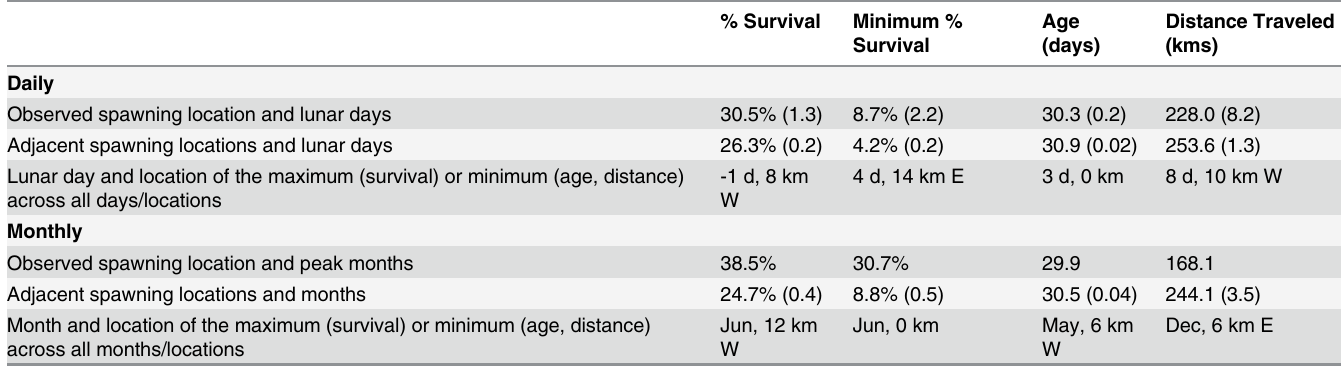
off Punta Hicacos (Fig 4b), which entrain larvae. The expected larval dispersal kernel (Fig 5) reflects the shorter duration and distance of larval trajectories inside the spawning window (Table 1) when advection by the Florida Current is weaker: more larvae released inside the spawning window remain close to shore and are retained near the point of release. Table 1. Metrics of larval success for observed and comparison spawning locations across lunar days and months. % Survival Minimum % Age Distance Traveled Survival (days)